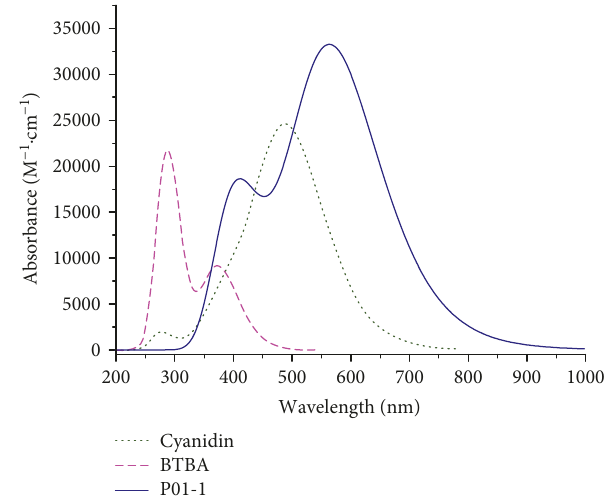
Figure 2: UV-Vis absorption spectra obtained for the P01-1 , BTBA , and cyanidin via the output of TDDFT calculations with the solvation e ff ect of ethanol